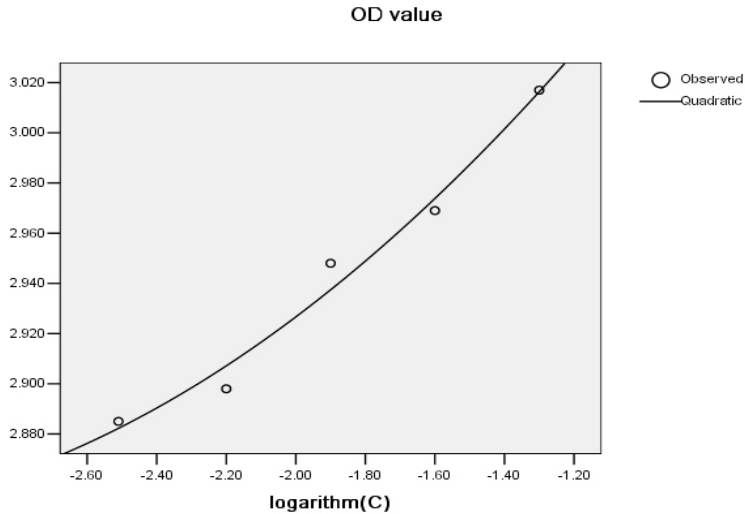
Figure 1. Regression curve of one sample. Where X represents the logarithm of sample dilution times, while Y represents the OD value.